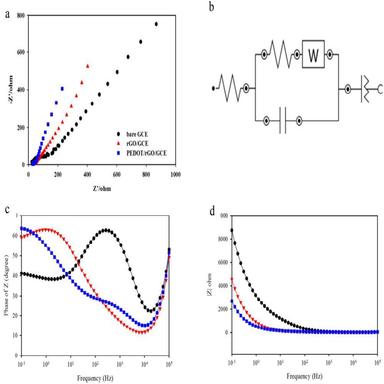
a) Modified Randles equivalent circuit; (b) Nyquist plot; (c) Bode phase and (d) Bode magnitude for the bare GCE, rGO/GCE and PEDOT/rGO/GCE in 5 mM K4 containing 1.0 M KCl solution.